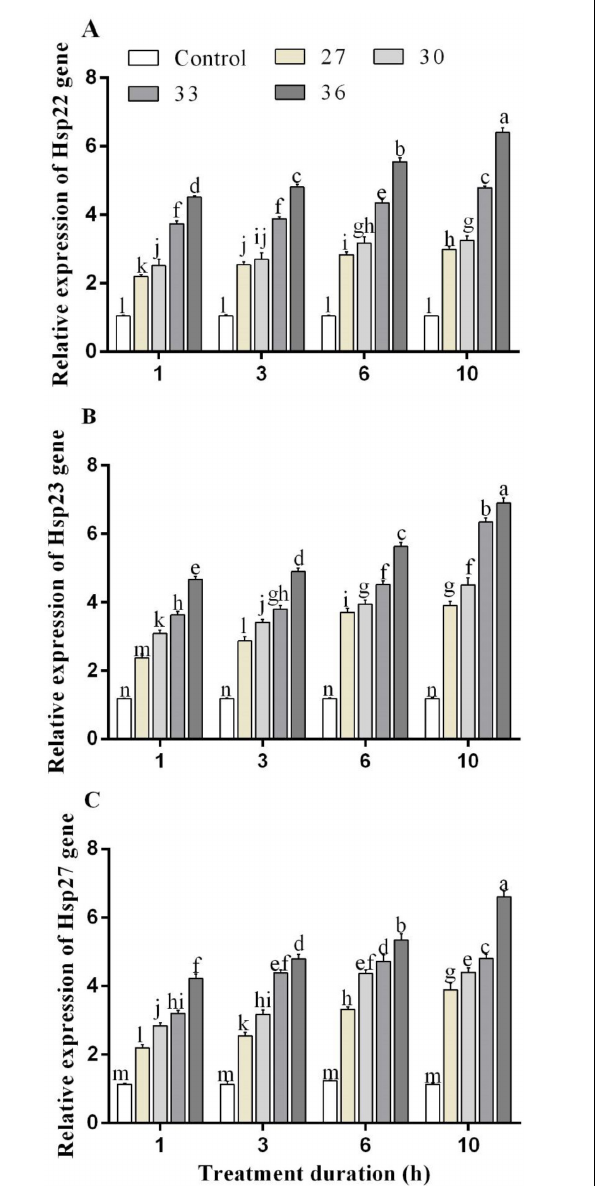
FIGURE 2 | Changes in (A) malondialdehyde (MDA) and (B) hydrogen peroxide (H 2 O 2 ) contents. (C) Effect of heat stress on survivability in M. persicae under different heat stresses (27, 30, 33, and 36 ◦ C) at different durations (1, 3, 6, and 10 h) in growth chambers. Small bars represent the SE of the means. Different lower case letters indicate significant differences between treatments at Tukey’s HSD test ( p < 0.05) using one-way ANOVA.